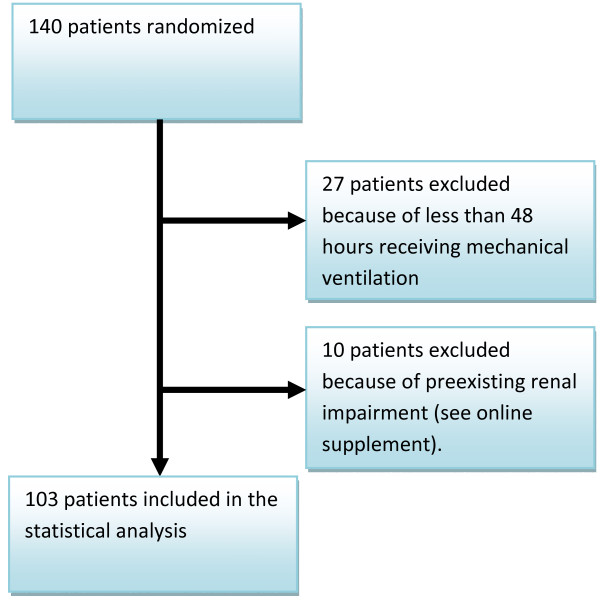
Consort diagram.